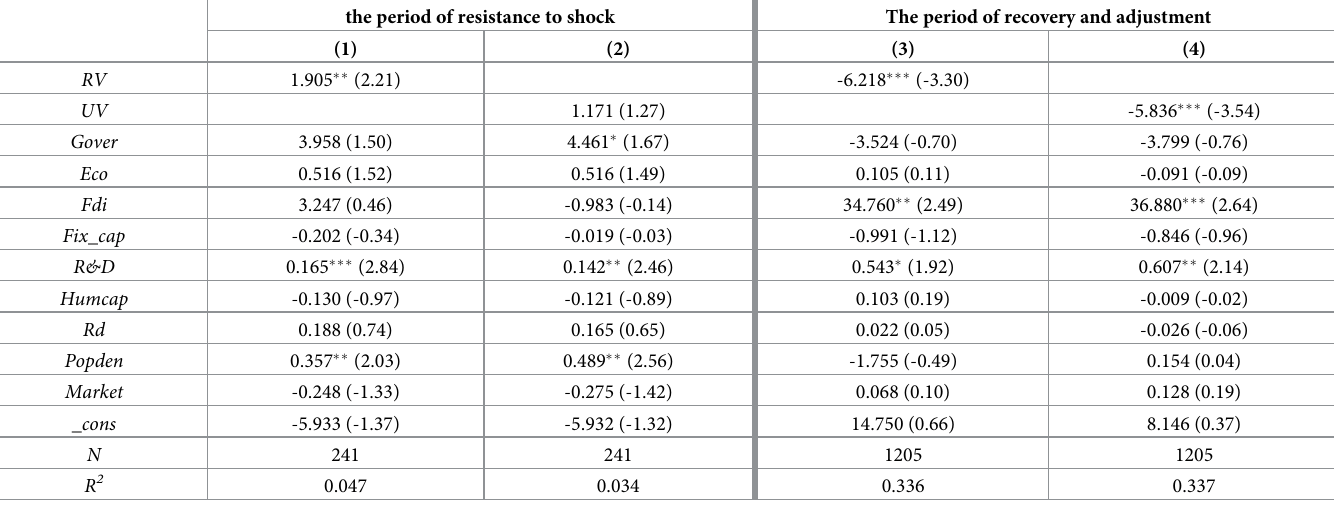
Table 3. The effects of two types of industrial diversification on urban economic